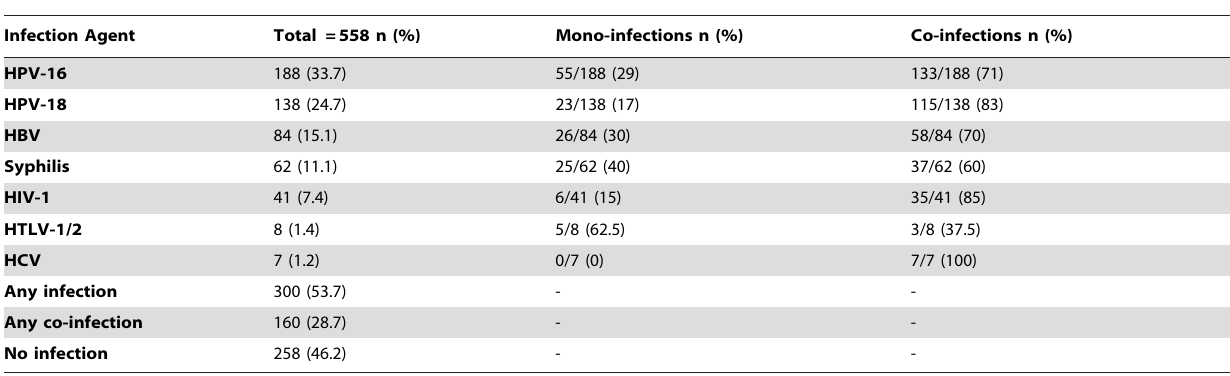
Table 4. Prevalence of mono-infections and co-infections.